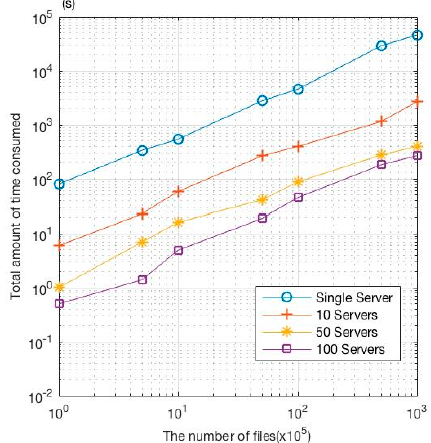
Figure 7. Efficiency of retrieval with different number of servers.